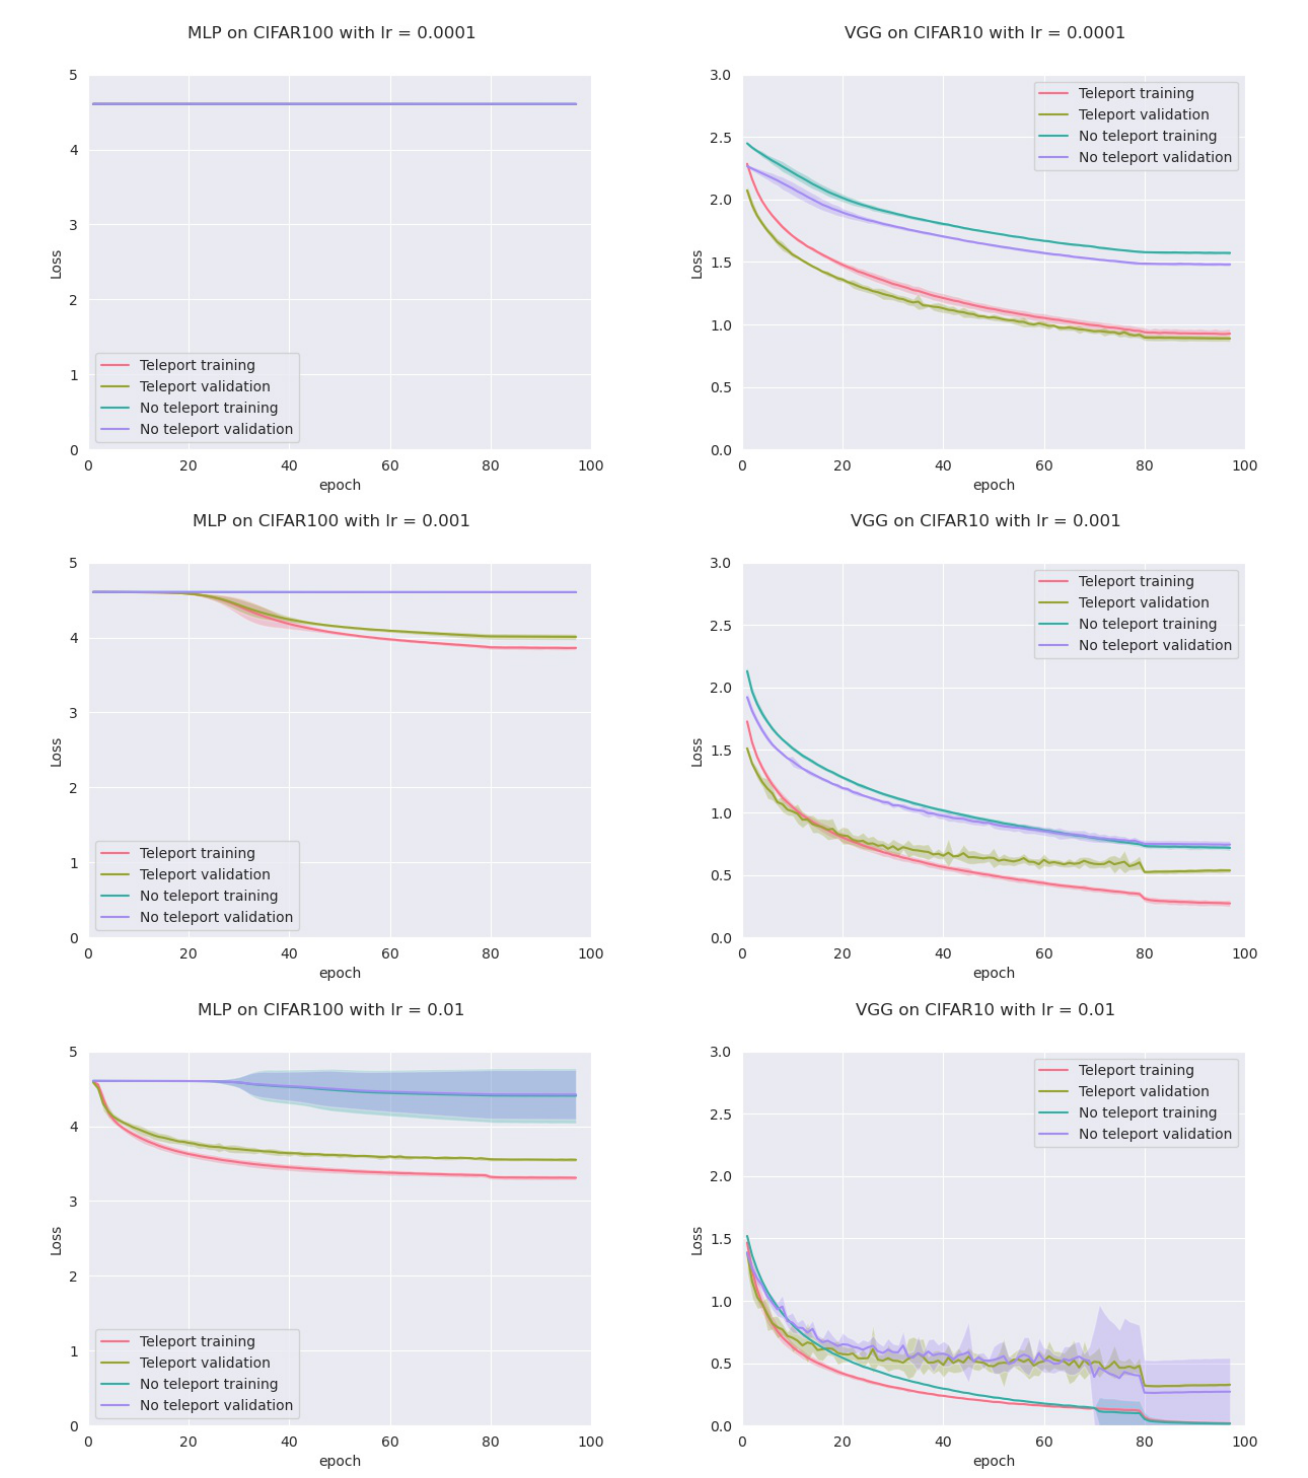
Figure A8. Average loss of MLP on CIFAR100 ( left ) and VGG on CIFAR10 ( right ) over 5 experiments, with and without teleportation, at the beginning of the training with CoB of 0.9. Learning rate increases from top to bottom rows. We also show a shadow around the average curves at two times the standard deviation over the five